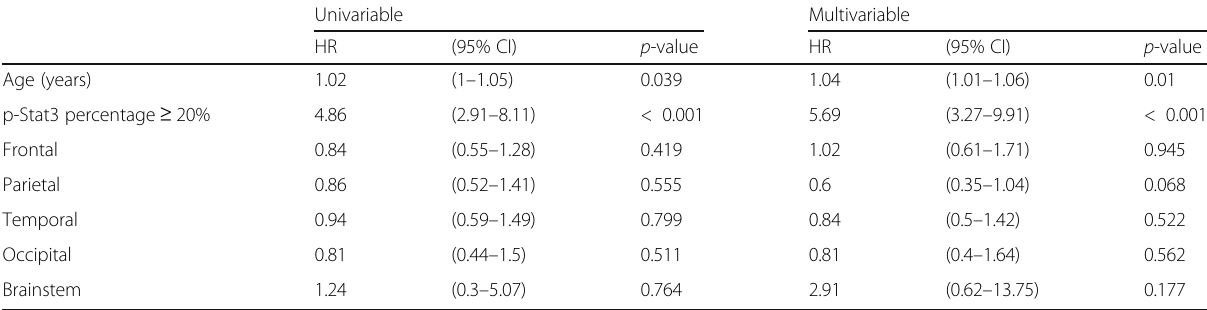
Table 2 Univariate and multivariate Cox proportional hazard regression models predicting overall survival Univariable Multivariable (95%